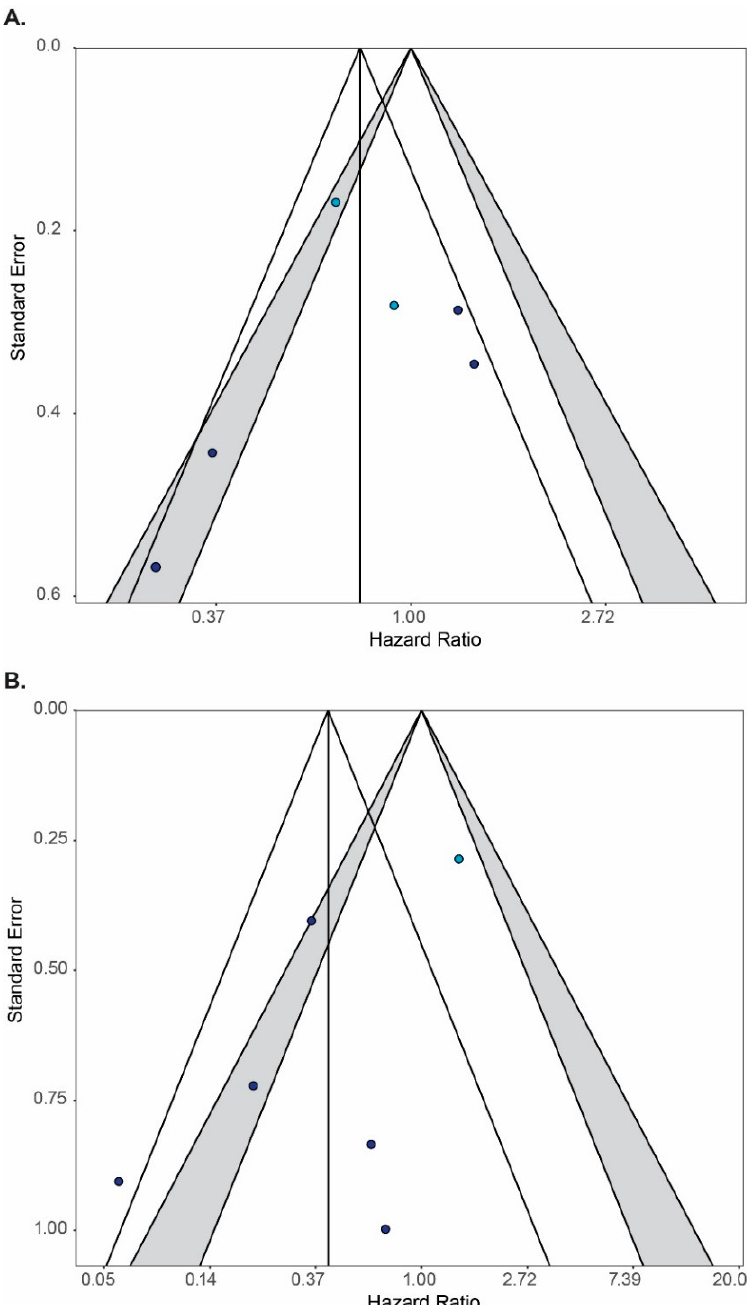
Figure 4. The assessment of the publication bias of studies included in the meta-analysis. Each circle represents a study included in the meta-analysis on overall survival; light blue circles are randomized controlled trials; dark blue circles are non-randomized controlled trials. The grey contours indicate the 95 and 99% confidence intervals of the hazard ratio for the impact of the addition of adjuvant systemic therapy to chemoradiation on the overall survival in the individual studies. The black vertical line is placed at the pooled estimate for the hazard ratio for overall survival based on the studies included in the meta-analysis. The black diagonal lines indicate the 99% confidence interval of the pooled estimate. Lack of symmetry in the presence of studies across the area defined by the black lines may indicate publication bias. Panel ( A ): Funnel plot of the studies on the addition of adjuvant platinum–pyrimidine antagonist after chemoradiation and brachytherapy. Panel ( B ): Funnel plot of the studies on the addition of adjuvant platinum–taxane after chemoradiation and brachytherapy.